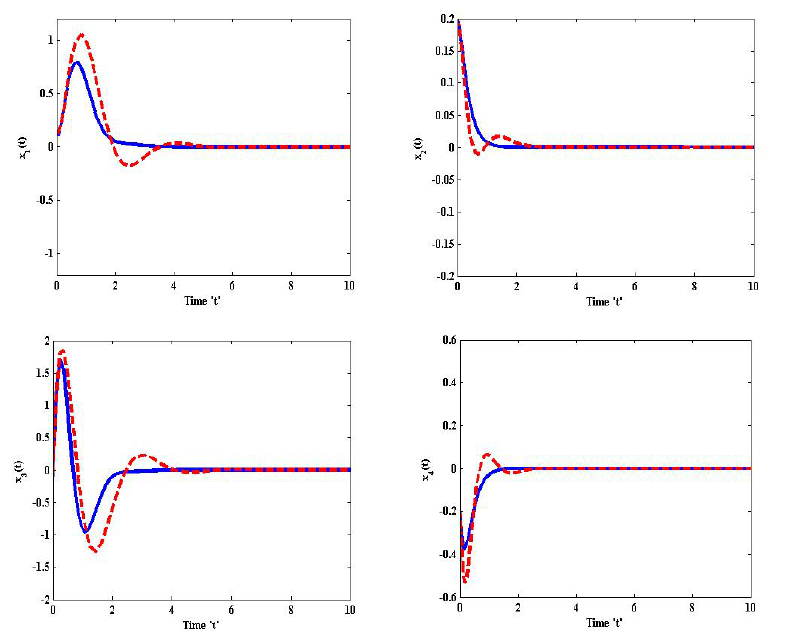
Figure 6. Displacement trajectories of controlled and uncontrolled for helicopter system